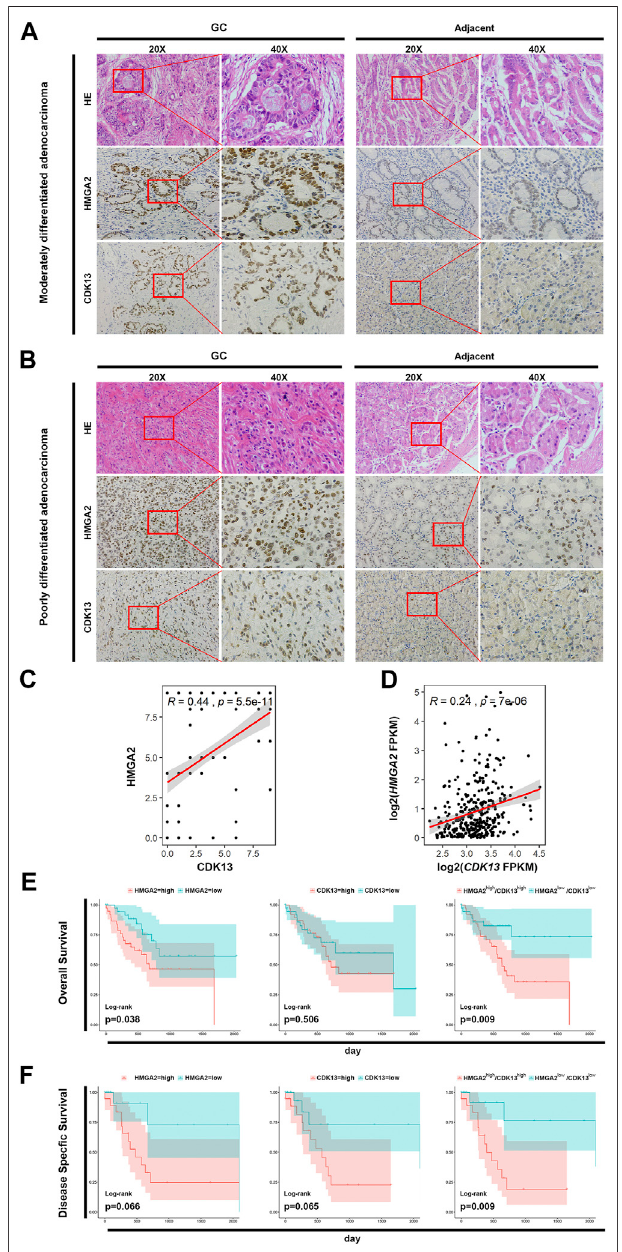
FIGURE 5 | HMGA2 and CDK13 are associated with tumorigenesis of GC. (A) Expression of HMGA2 and CDK13 in the tissues of the patients with moderately differentiated STAD.The left twocolumns aretheHE stainingand immunohistochemical results of the GC tissue. The right two columns are those from the adjacent tissue. For both GC and the adjacent group, respectively:the fi rstcolumn, × 20;thesecondone,imagesmagni fi edfromthe red frames ofthe left side, × 40. Compared with thecorrespondinglocationof the adjacent tissue, the morphological disorder of cell arrangement is obvious in the GC tissue although the glands exists, which is consistent with the characteristics of this type of GC. The brown colored nuclei in the images of the second and the third horizontal line suggest HMGA2 positive and CDK13 positive, respectively. Therefore, the expressions of HMGA2 and CDK13 in GC are much higher than those in the adjacent tissue. (B) Expression of ( Continued )